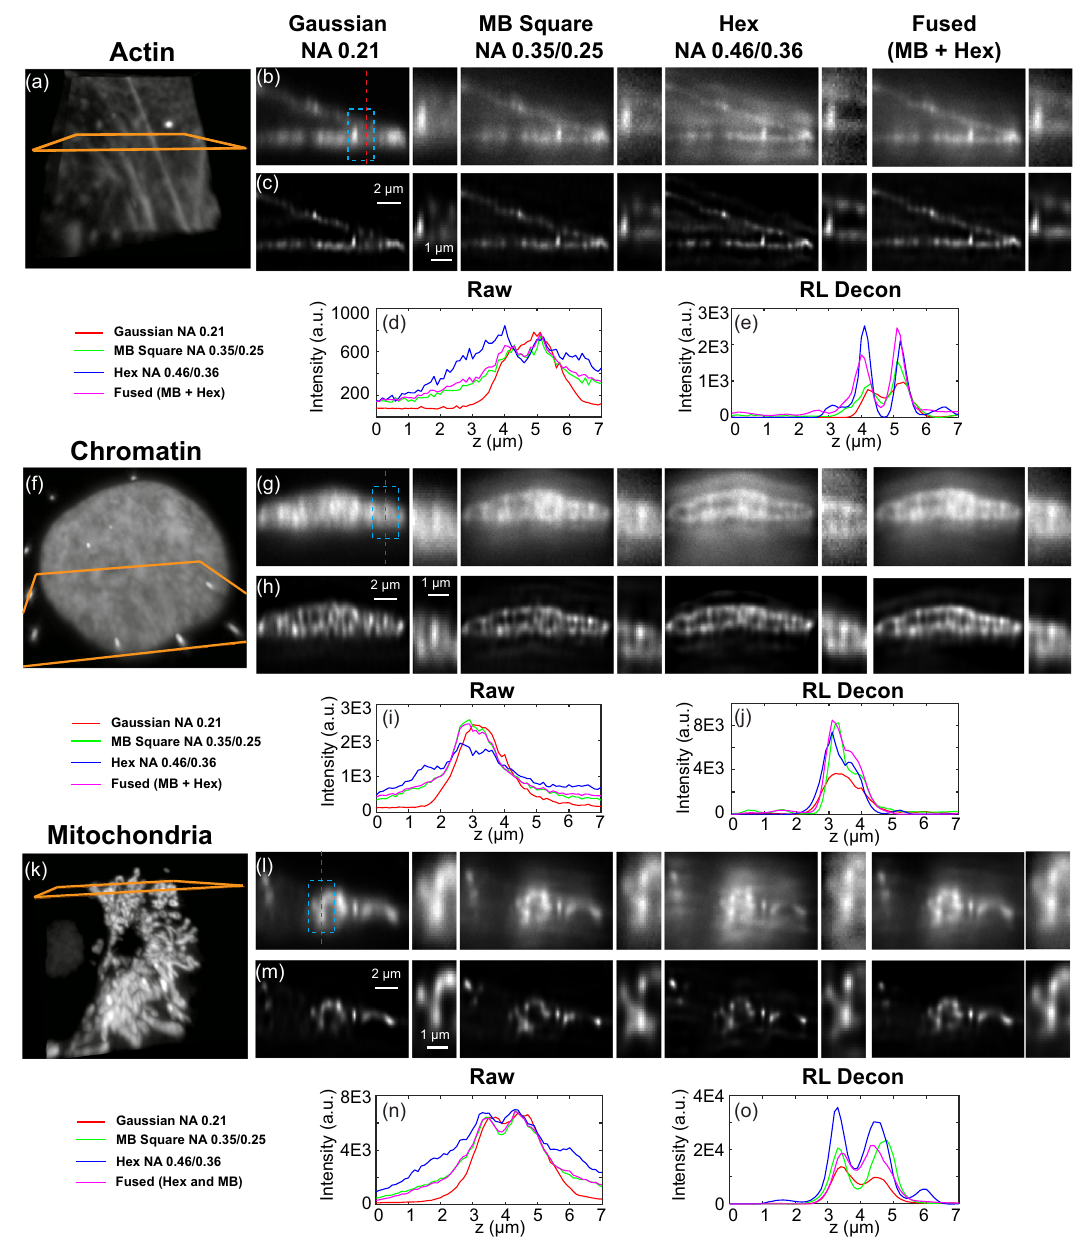
Fig.4|Comparativeimagesof fi xedsubcellularstructures.a 3Doverviewofthe actin fi lamentstructuresinthecell.TheorangeoutlineshowstheROIsliceusedfor ( b , c ). b , c Raw and RL deconvolved YZ slices taken with the three different beams and a fused MB-square+hexagonal condition. The cyan bounding box is enlarged